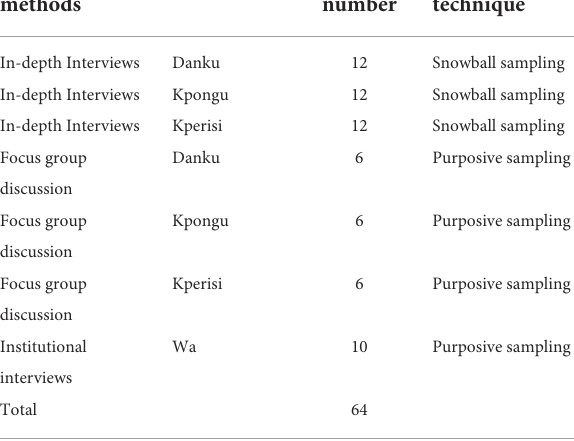
TABLE 1 Number of respondents and methods of data collection used in the